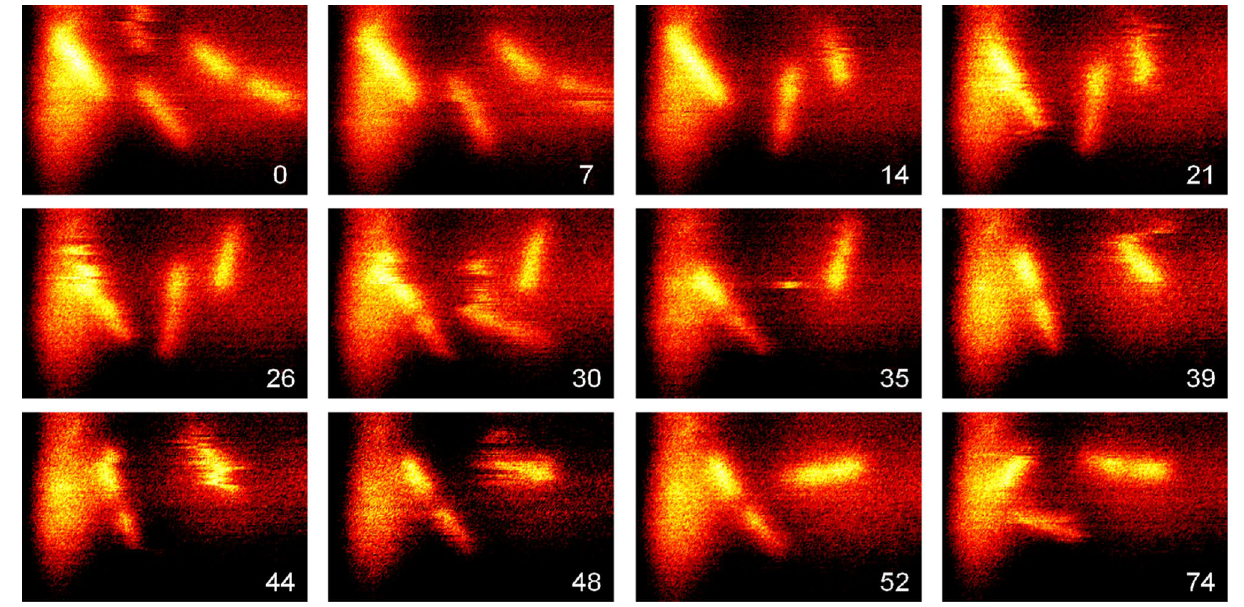
Figure 5. Adhesion-localised, but mobile living E. coli cells, sequential s-SNOM infrared amplitude s 2 images as cells adhere, grow and move in the medium under a 15 nm SiN membrane (Norcada NBPX5002YZ-HR), at times (min) indicated, color scale as in Fig. 4A, image size 7.5 × 5 µm 2